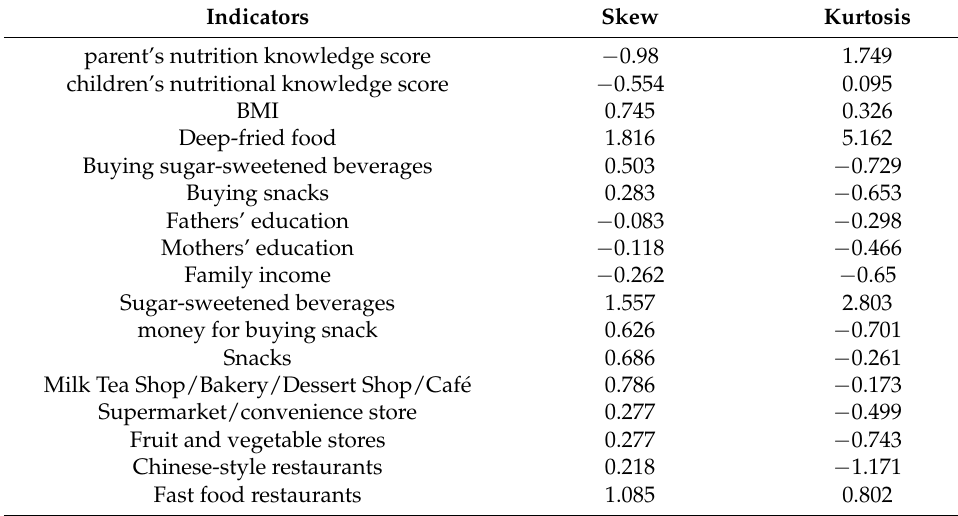
Table A3. Normality analysis.